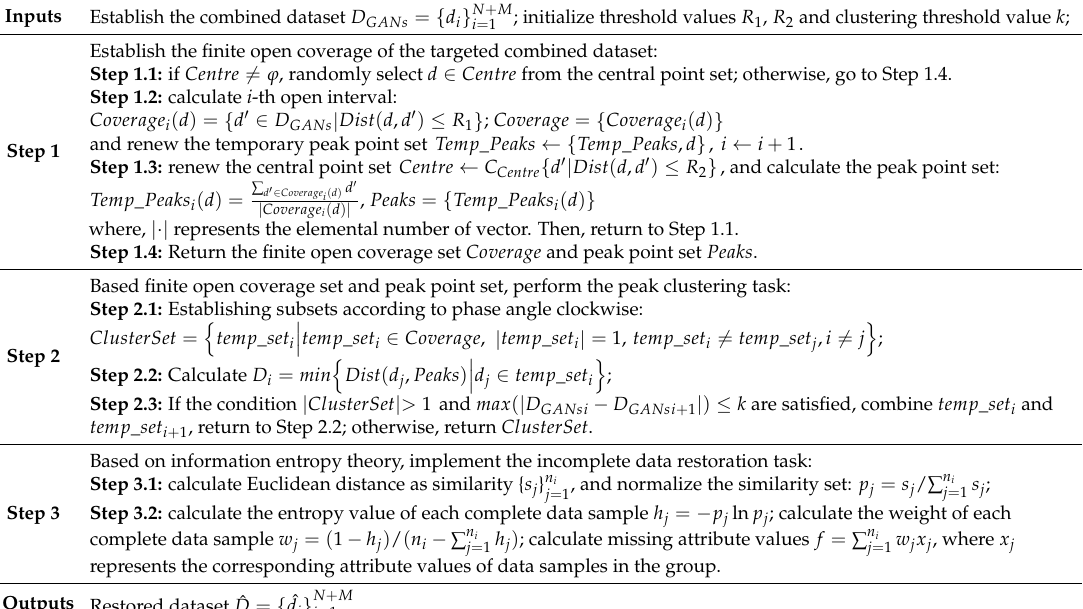
Table 1. Peak clustering based data restoration algorithm.